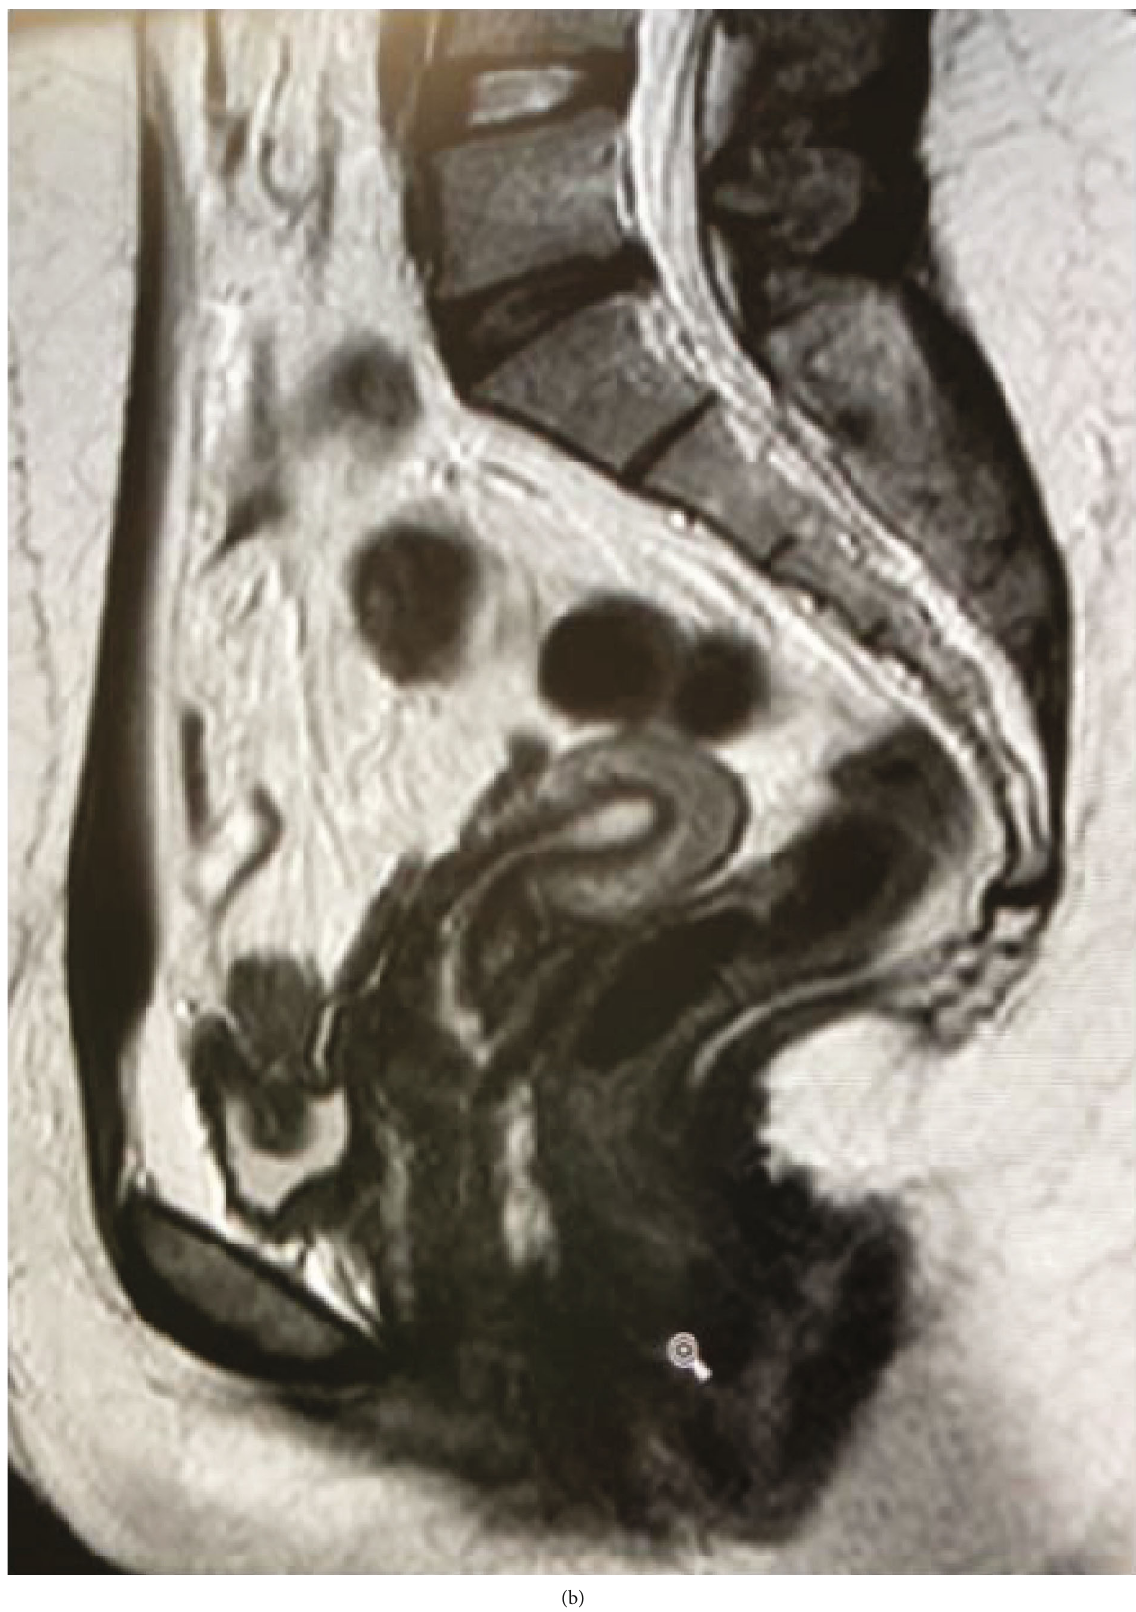
Figure 2: Magnetic resonance T2 weighted images. (a) Low uterine segment appearance at diagnosis. (b) Low uterine segment appearance after